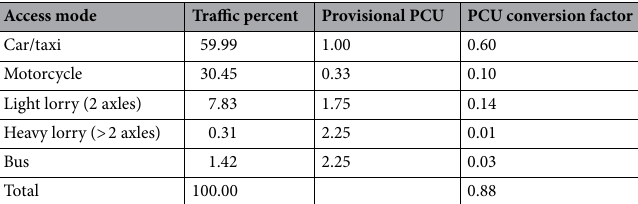
Table 2. Example of PCU conversion factor from MTGM 1